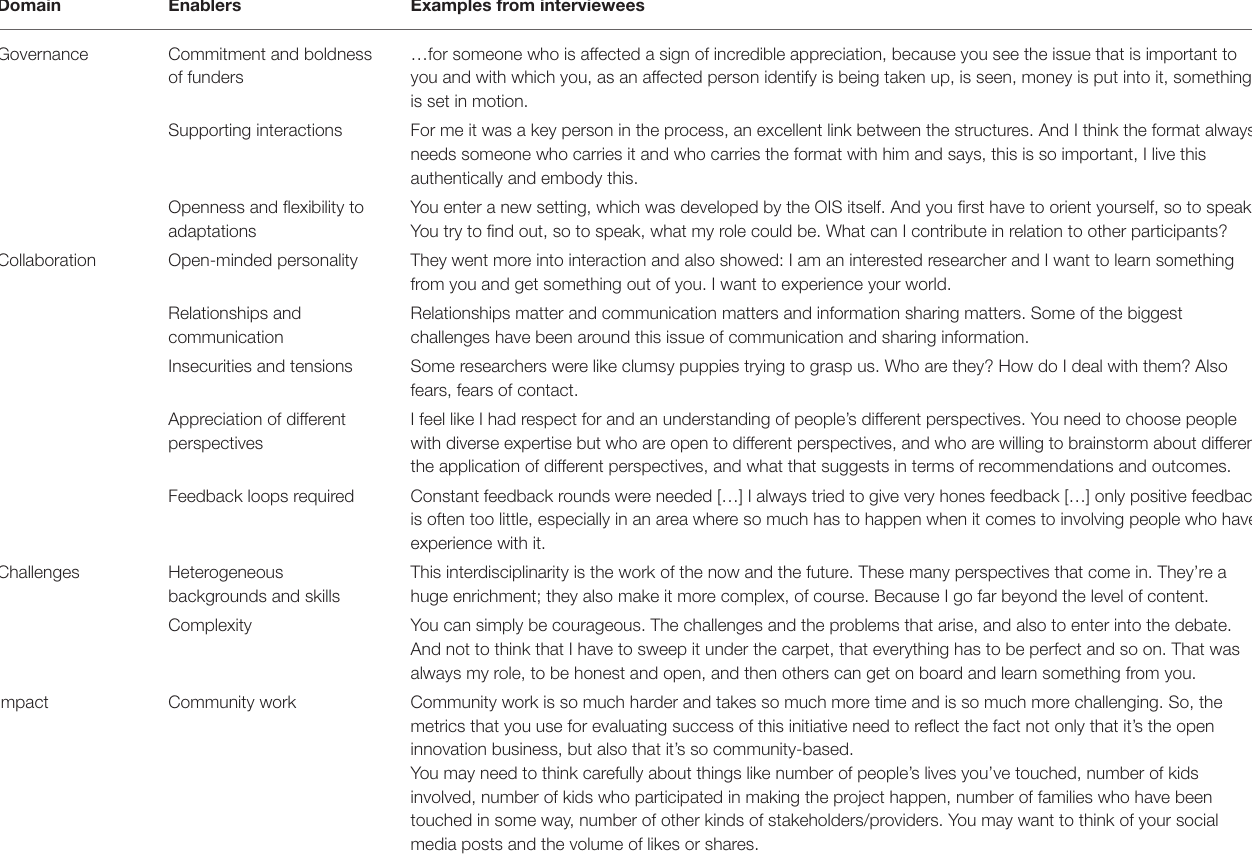
TABLE 1 | Summary of enablers for successful, transdisciplinary